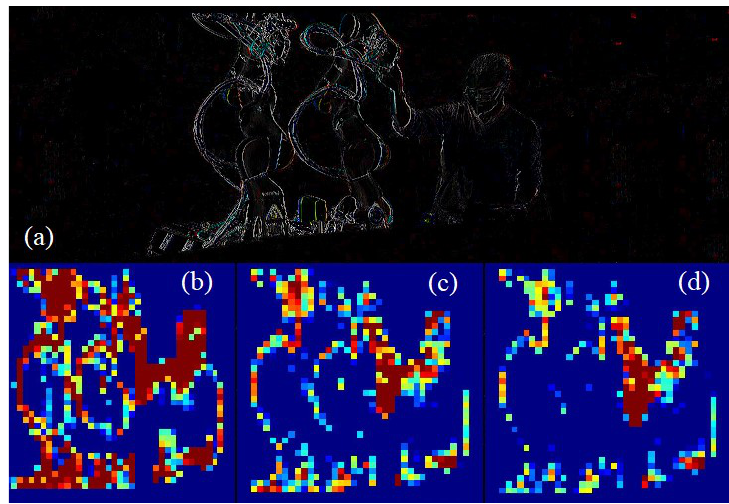
Figure 7. Monitoring of the Cobot environment activity: ( a ) Image of activity difference in two consecutive frames. ( b ) Activity (A) in a frame. ( c ) ∆ A in a frame ( d ) ∆∆ A in a frame .